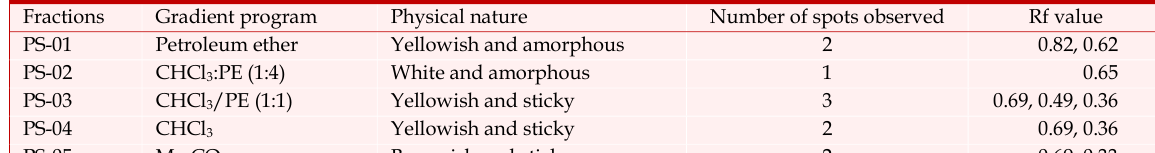
TLC profile of the column